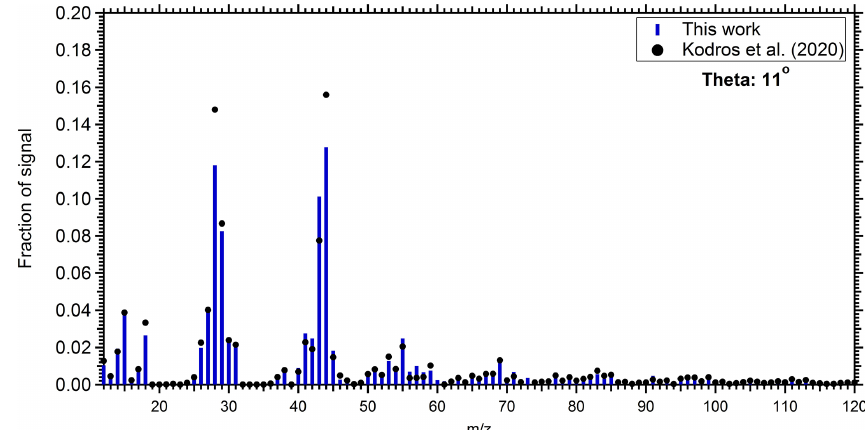
Figure 6. Comparison of the produced SOA mass spectra in the perturbed chamber during Exp. 1 (blue bars), and the produced SOA estimated during the chamber experiments of nocturnal aging of biomass burning emissions (Kodros et al., 2020; black circles).